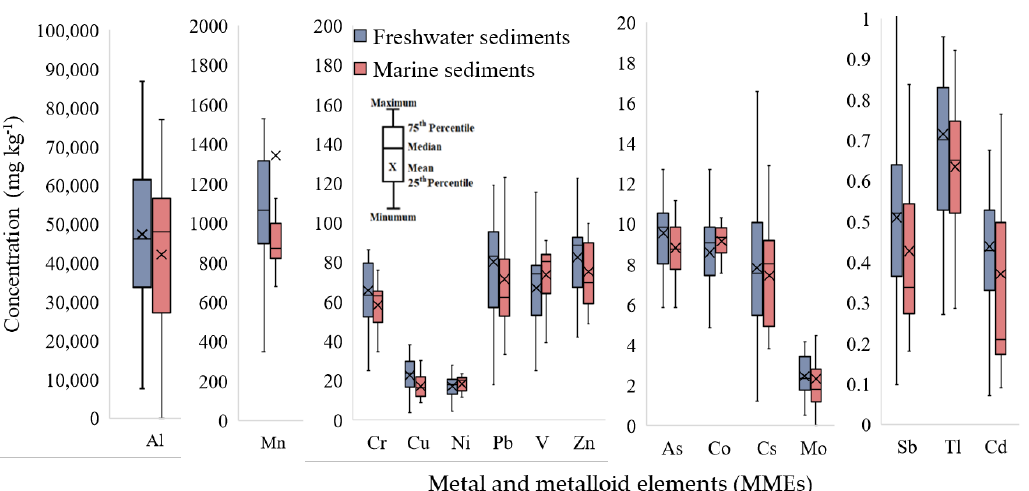
Figure 3. Box and whisker plot for the concentration (mg kg − 1 ) of metal and metalloid elements (MMEs) in freshwater and marine sediments.